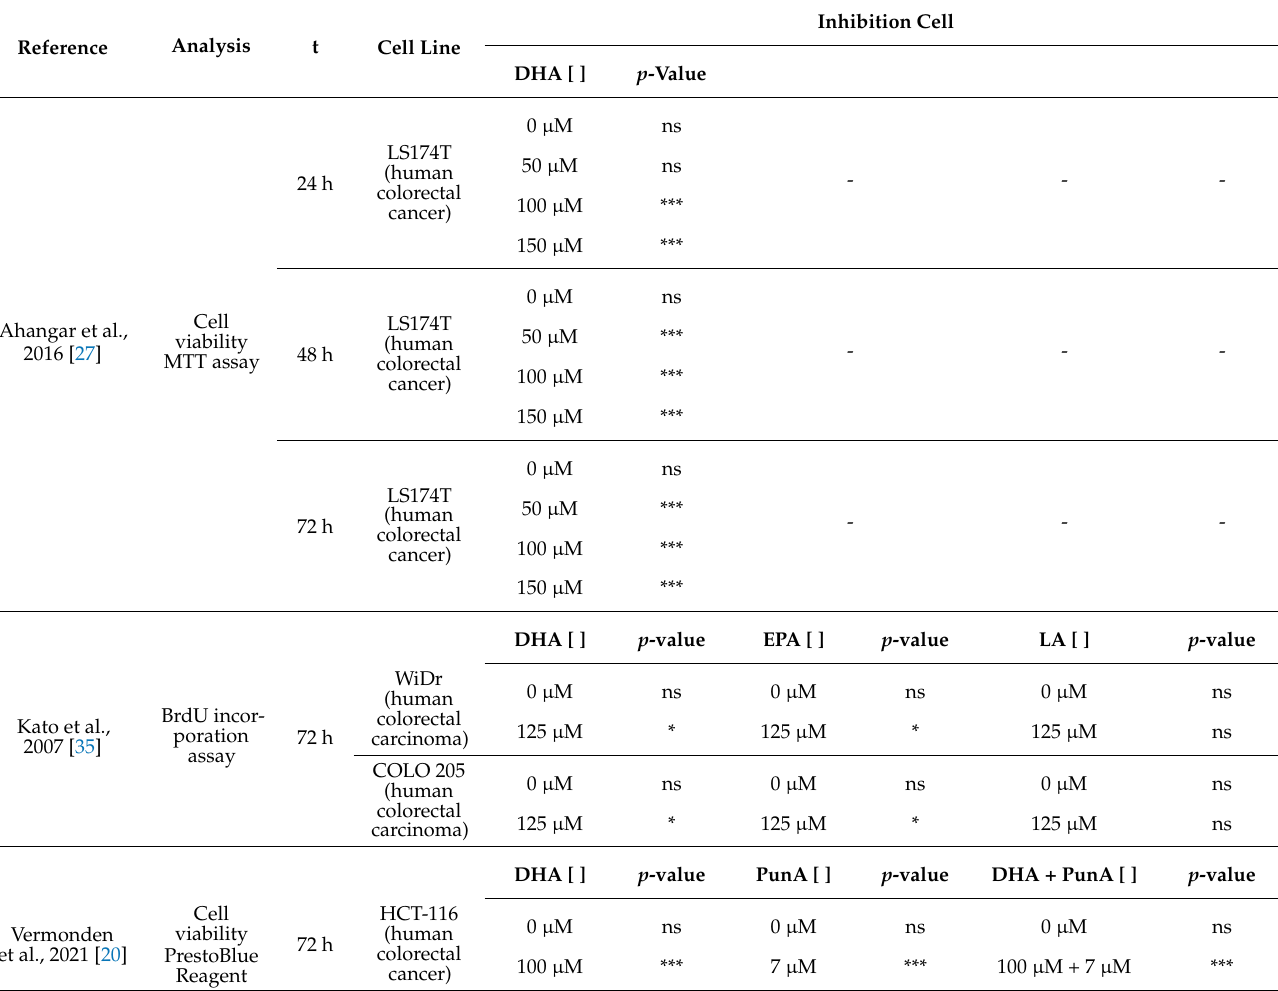
Table 4. Analysis results of the in vitro cytotoxicity tests on colorectal cancer cell